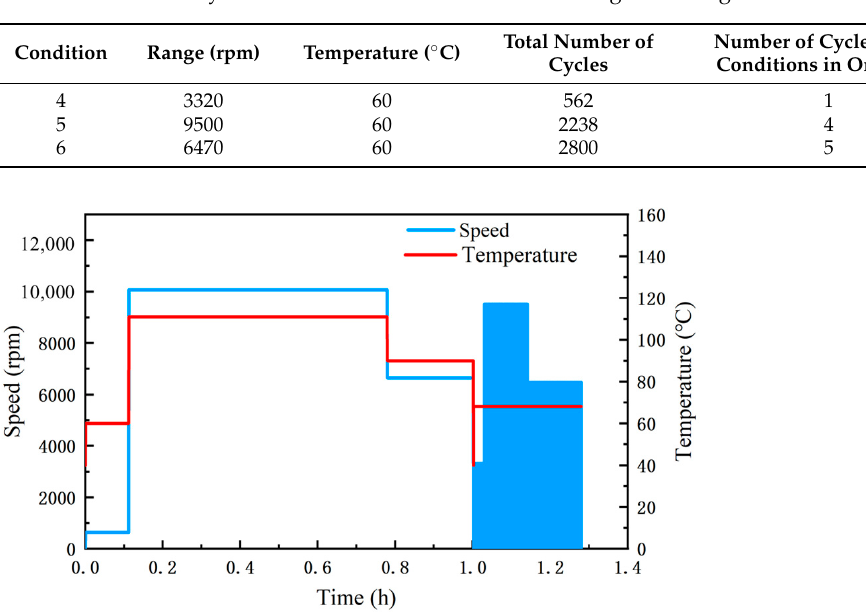
Table 8. Number of cycles for each test condition in alternating loads fatigue mode.